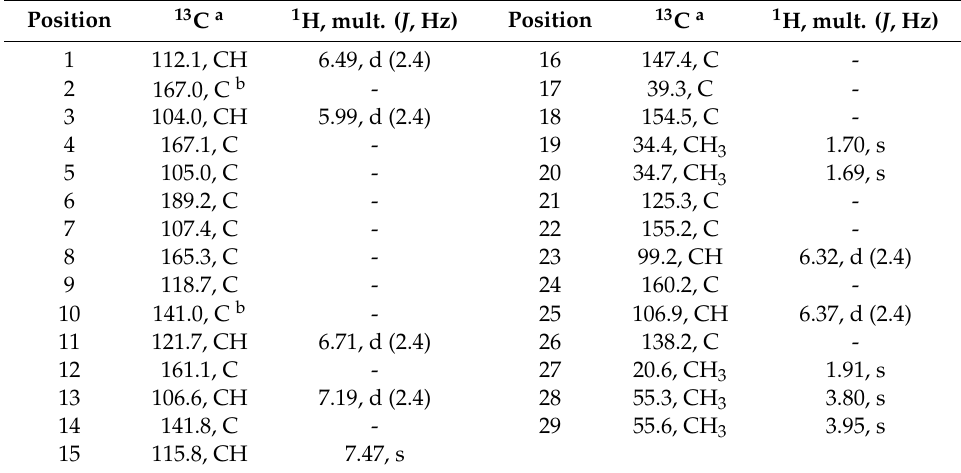
Table 1. NMR data for accramycin A 1 (CD 3 OD, 600 MHz at 298